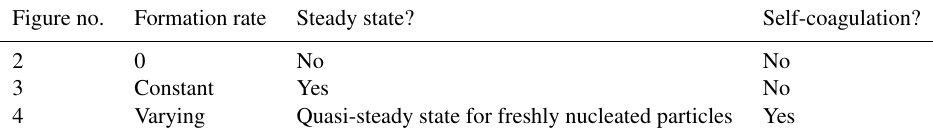
Table 1. Simulation conditions for Figs. 2–4. Figure no. Formation rate Steady state? Self-coagulation? 2 0 No No 3 Constant Yes No 4 Varying Quasi-steady state for freshly nucleated particles